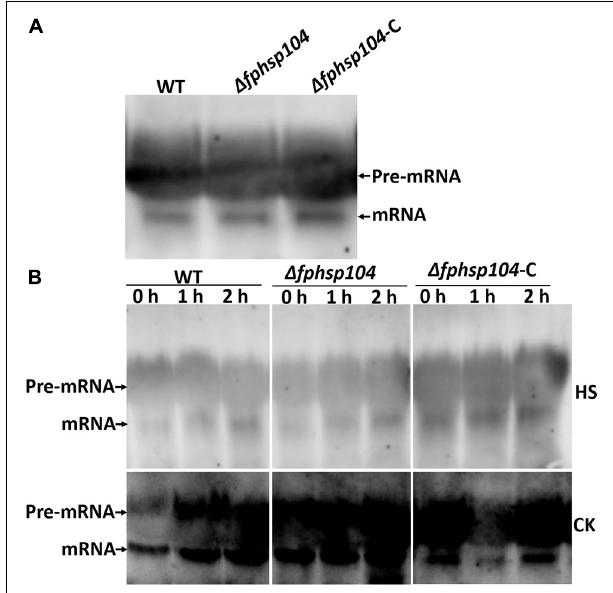
FIGURE 7 | mRNA splicing after heat shock. (A) Conidia inoculated in YEPD at 25 ◦ C for 12 h. Total RNA of the actin gene was detected using Northern blotting. (B) Germinated conidia were heat-shocked at 34 ◦ C for 2 h (HS) or not (CK) and returned to 25 ◦ C for 0, 1, or 2 h. Total RNA of the actin gene was detected using Northern